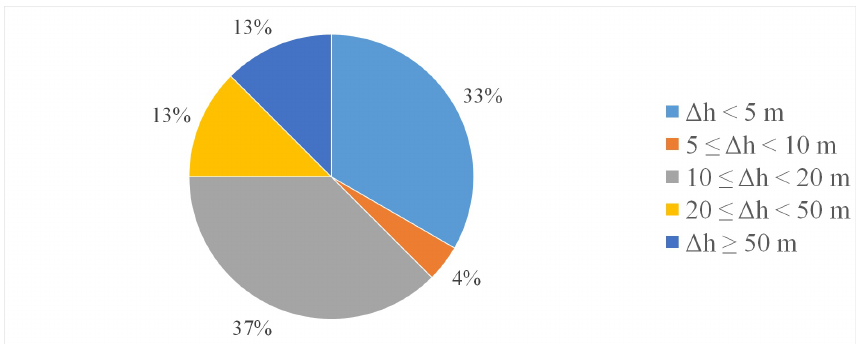
Figure 9. Category #5: inserted pressure wave, ∆ h . Percentages of the papers for the five